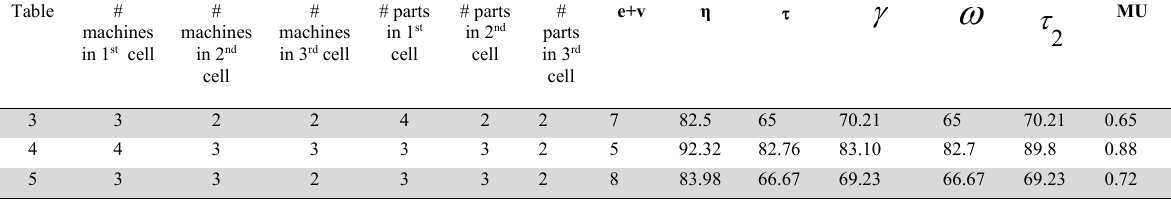
Evaluation of different measures for problem 1(efficiency of block-diagonal